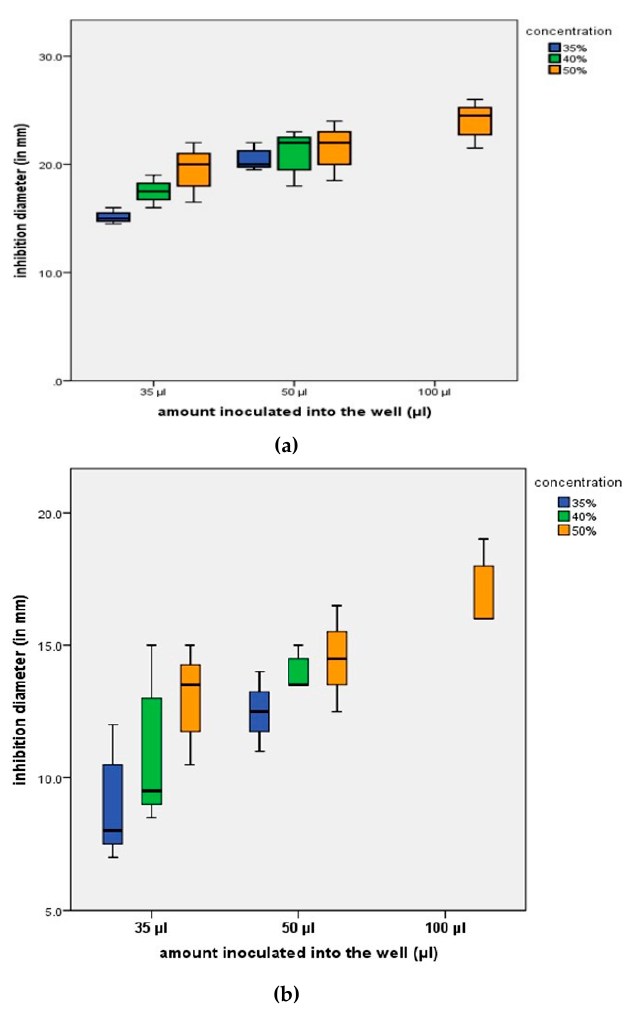
Figure 4. Mean values of inhibition diameters for P. anaerobius strain ( a ) and for C. xerosis strain ( b ) as a function of concentrations and quantities.